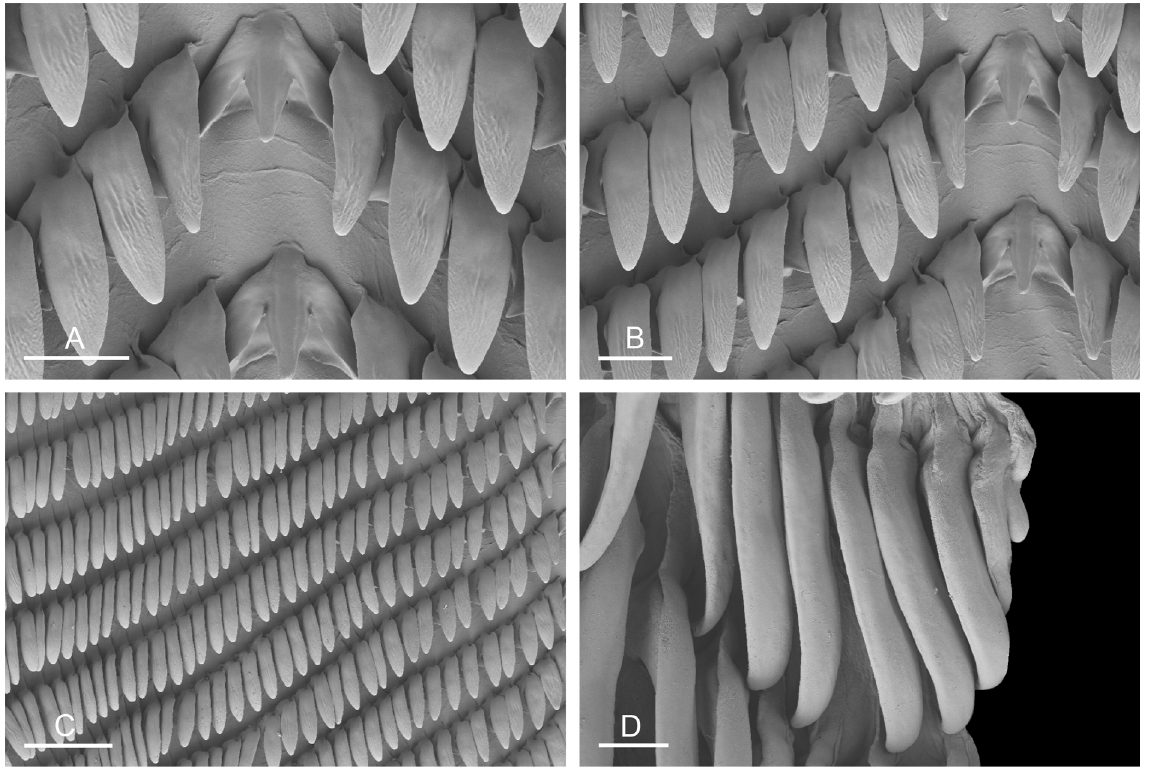
Fig. 50. Paromoionchis goslineri gen. et sp. nov. unit #2, radula, Indonesia, Bali [3078] (UMIZ 00155). A . Rachidian and innermost lateral teeth. B . Lateral teeth with rachidian teeth. C . Lateral teeth. D . Outermost lateral teeth. Scales: A–B = 20 μm; C = 30 μm; D = 10